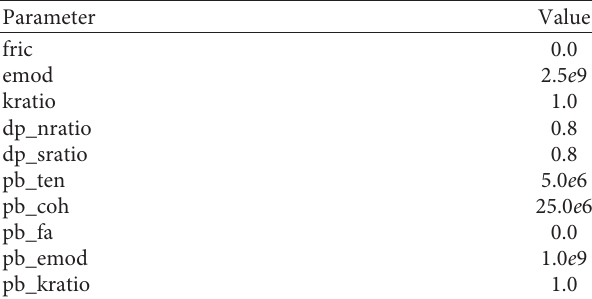
Table 1: The meso-parameters in the